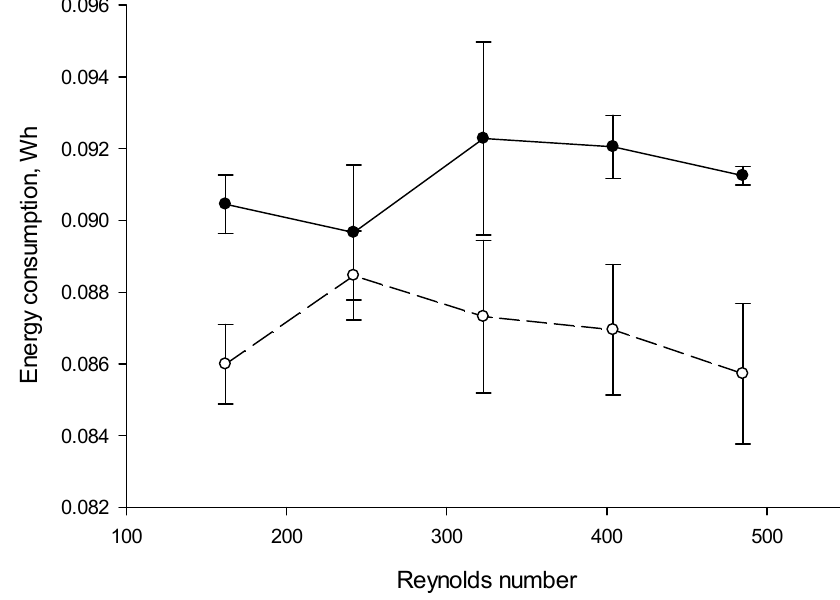
Figure 8. Energy consumptions (in Wh) during EDBM depending on the Reynolds numbers under CC and PEF current mode (PEF in dashed line and CC in solid line). Reynolds numbers of 162, 242, 323, 404, and 485 correspond to flow rates of 400, 600, 800, 1000 and 1200 mL / min respectively. CC—constant current and PEF—pulsed electric field.